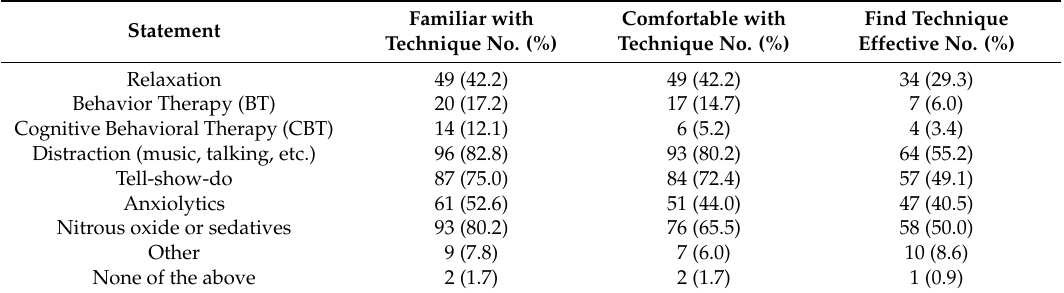
Table 3. Ohio dentists’ clinical preferences for techniques used to treat patients with dental anxiety.